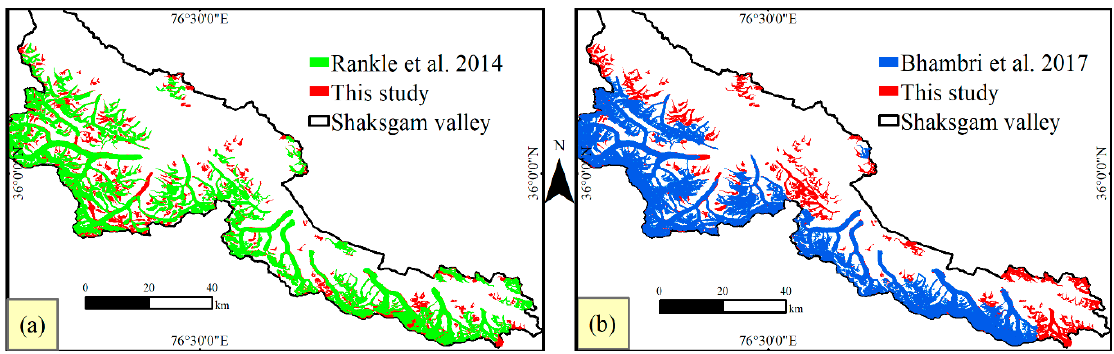
Figure 2. Comparisons of coverage of glacier inventories from previous studies with this study.